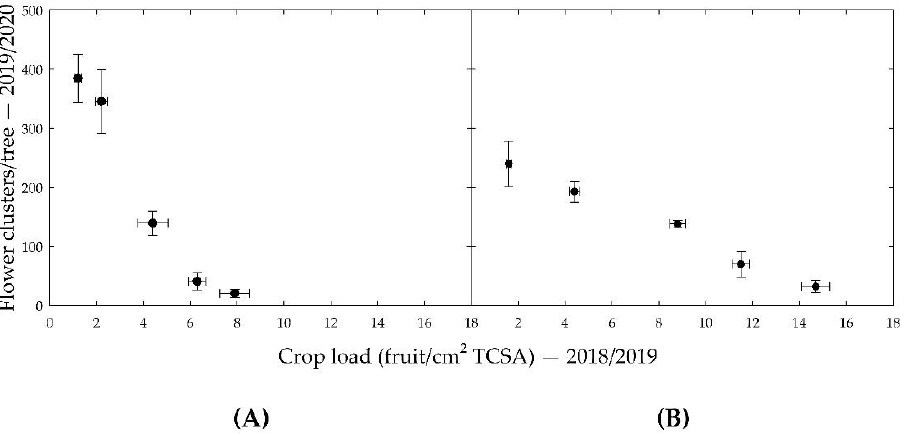
Figure 1. Flower clusters counted on trees in the 2019/2020 season against the crop loads (fruit/cm 2 tree’s trunk cross sectional area (TCSA) ) of those trees in the 2018/2019 season for: ( A ) ‘Nicoter’; ( B ) ‘ Rosy Glow ’. Each point is the average of three trees with standard error bars.